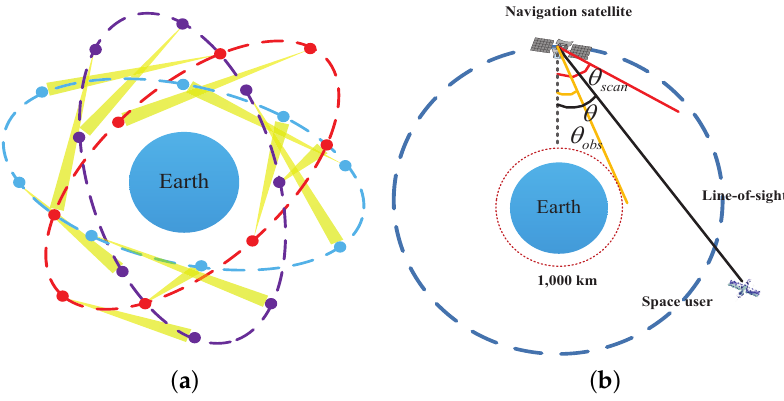
Figure 3. Geometry of ISLs at a specific time: ( a ) ISL signals among the navigation satellites; and ( b ) ISL signal to space